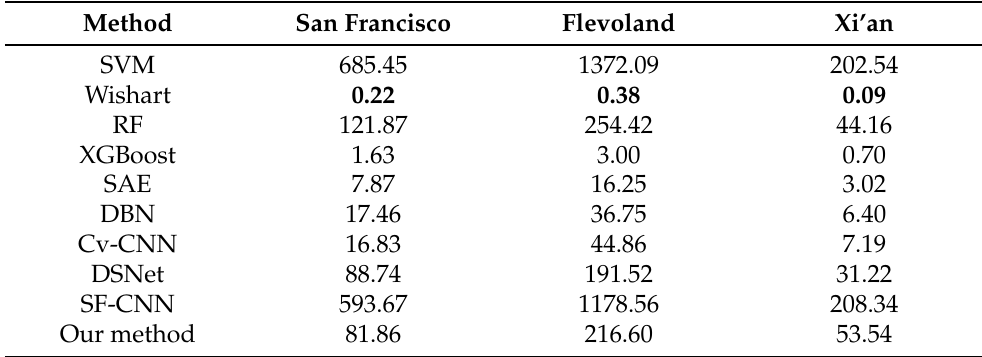
Table 5. Computational time (second) for inference of different methods, where the minimum value for every class is are marked in bold.